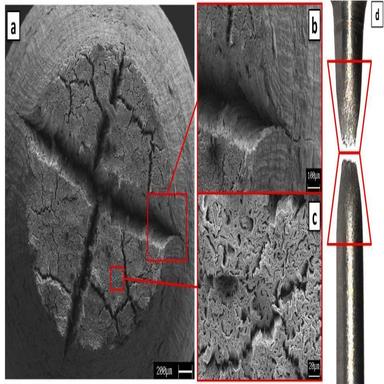
(a) SEM image of "G-A bar.m.1" specimen fracture surface; (b)(c) SEM images of fracture surfaces displaying two magnification; (d) image after the static test showing necking and fracture of specimen.